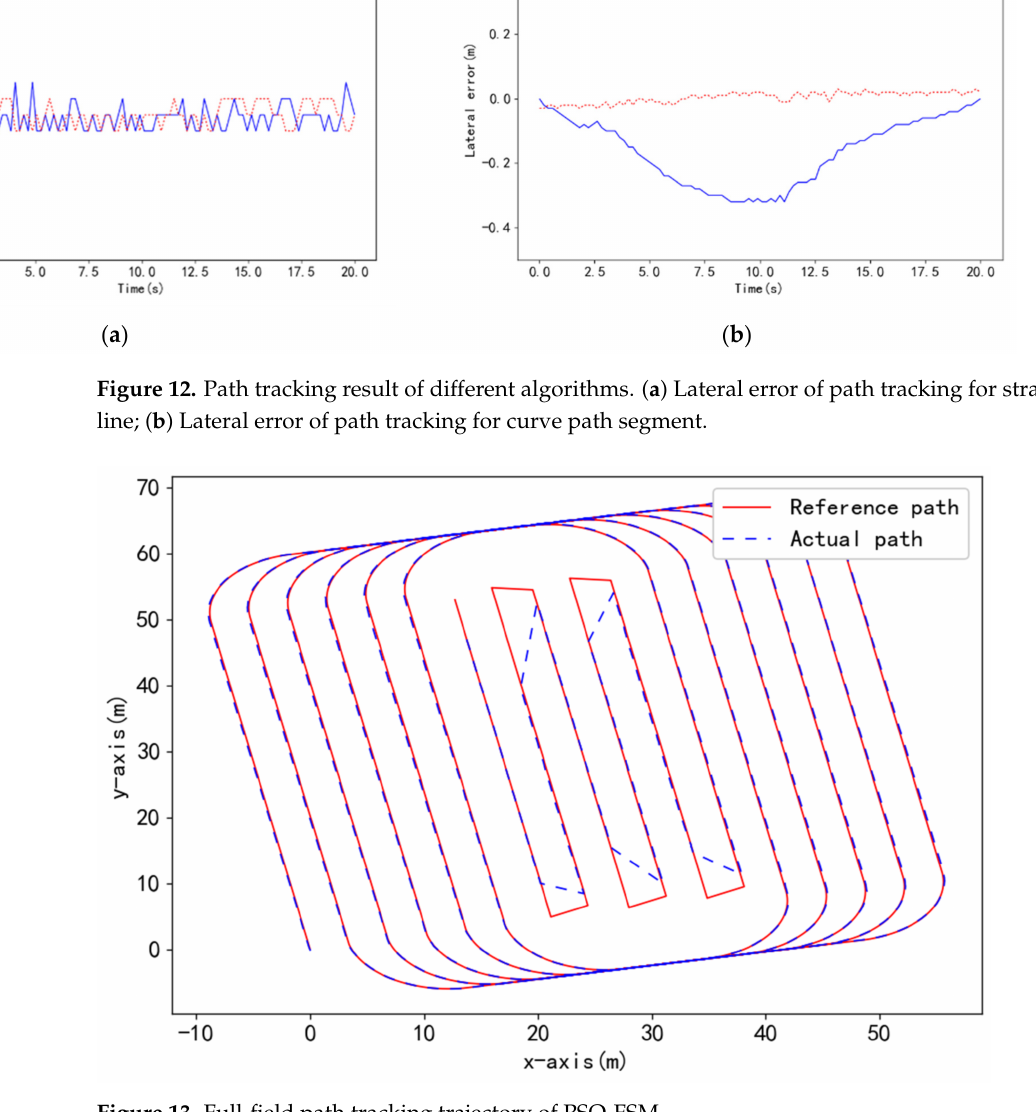
Figure 13. Full-field path tracking trajectory of PSO-FSM. Table 3. Full-field path tracking error of the mobile